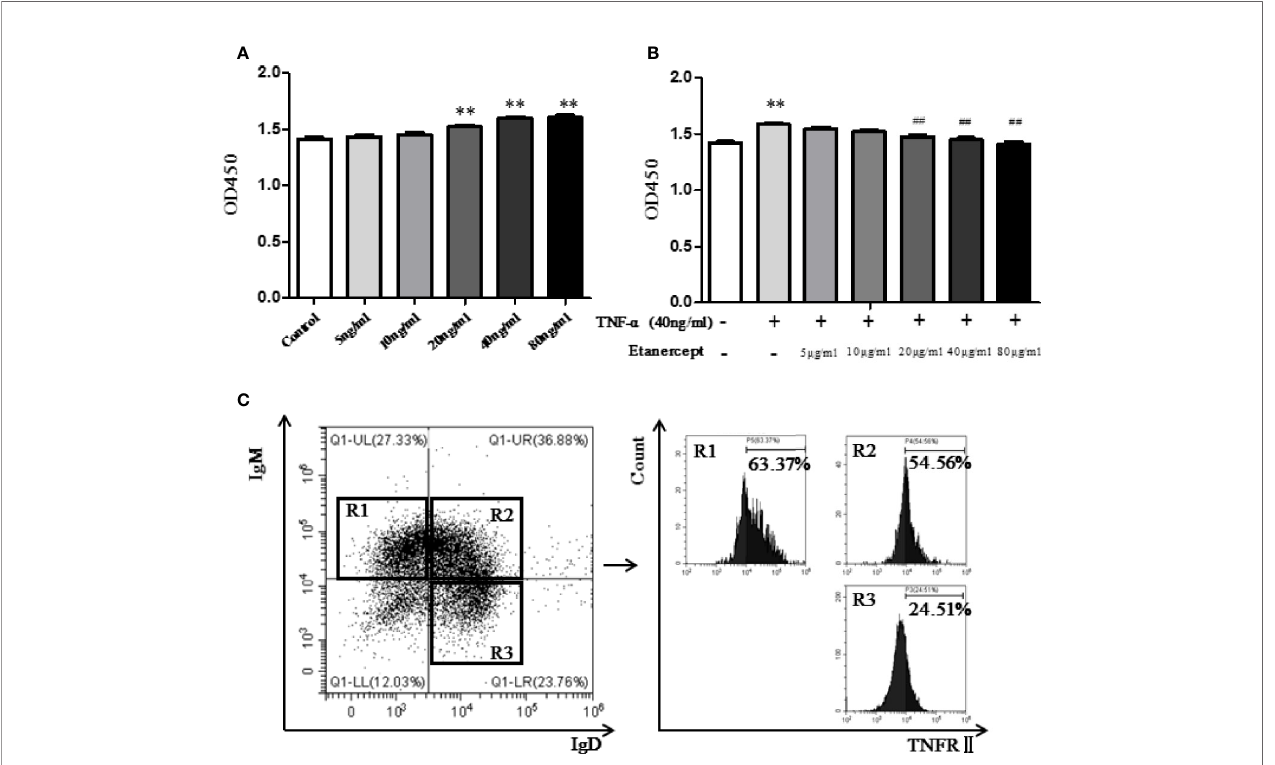
FIGURE 5 | (A) The effect of different concentrations of TNF- a on the proliferation of B cells was detected by CCK-8. (B) The effect of different concentrations of etanercept on the proliferation of B cells stimulated by TNF- a was detected by CCK-8. (C) Expression of TNFRII on type I transitional B cells (CD19 + IgM + IgD − ), type II transitional B cells (CD19 + IgM + IgD + ), and mature B cells (CD19 + IgD + IgM − ) by fl ow cytometry. ## p < 0.01 vs TNF- a group, ** p < 0.01 vs Control